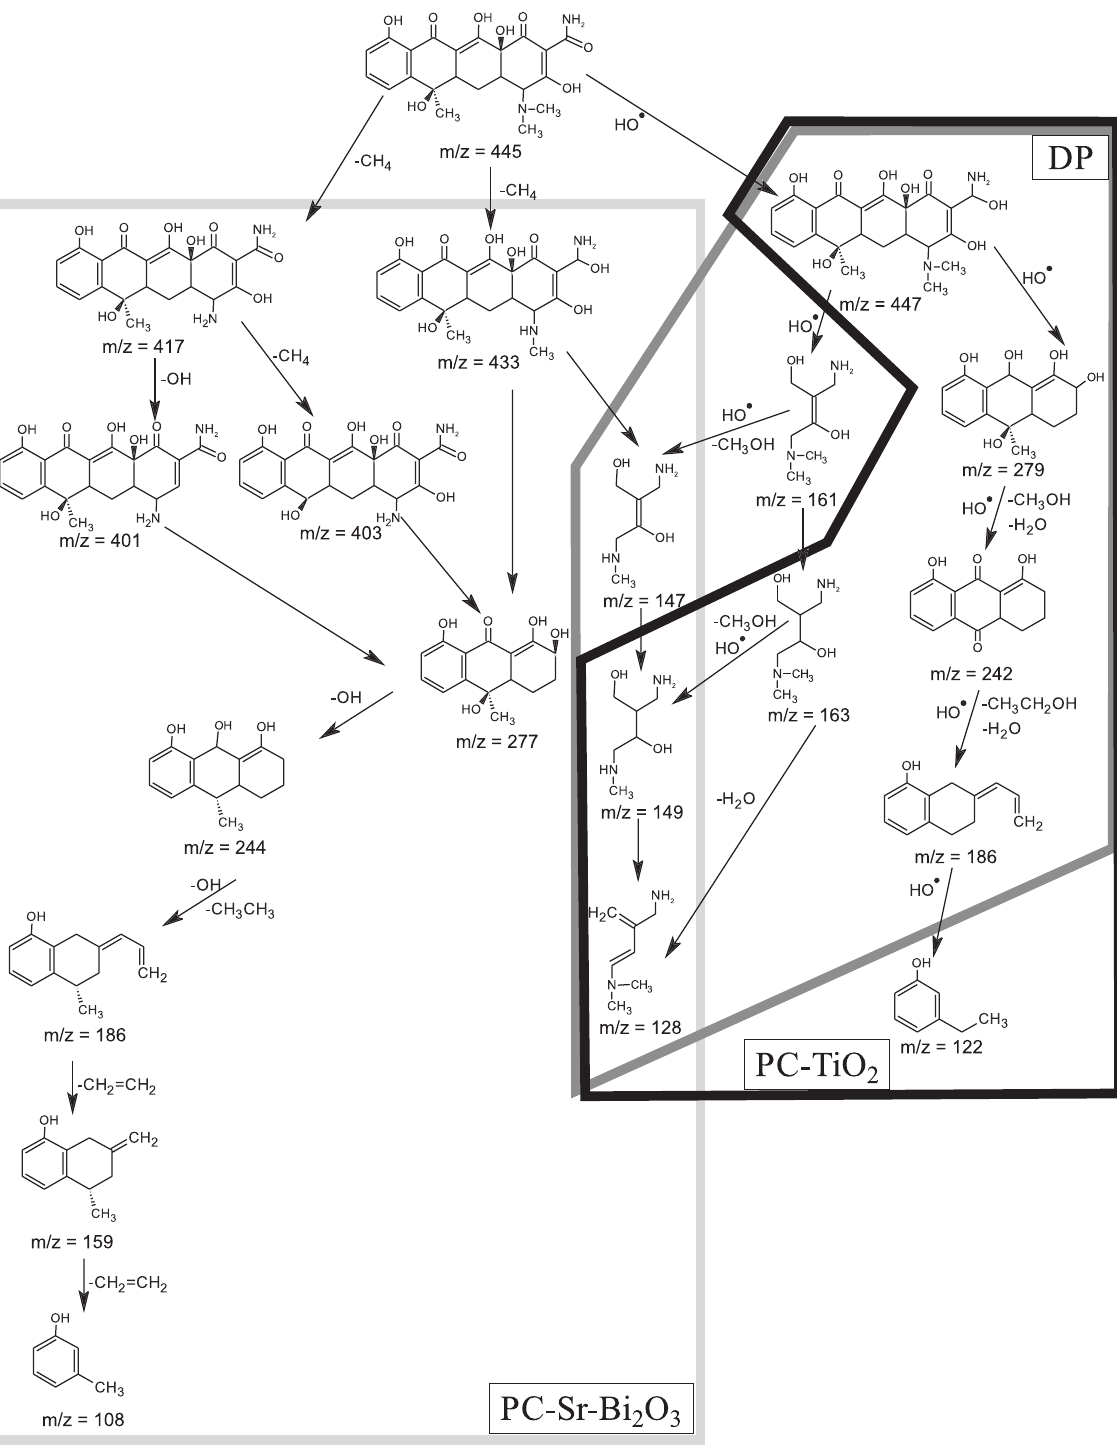
FIGURE 5 – Degradation products of tetracycline through  direct photolysis,  photocatalysis with TiO with Sr-Bi O (adapted from Niu et al ., 2 3